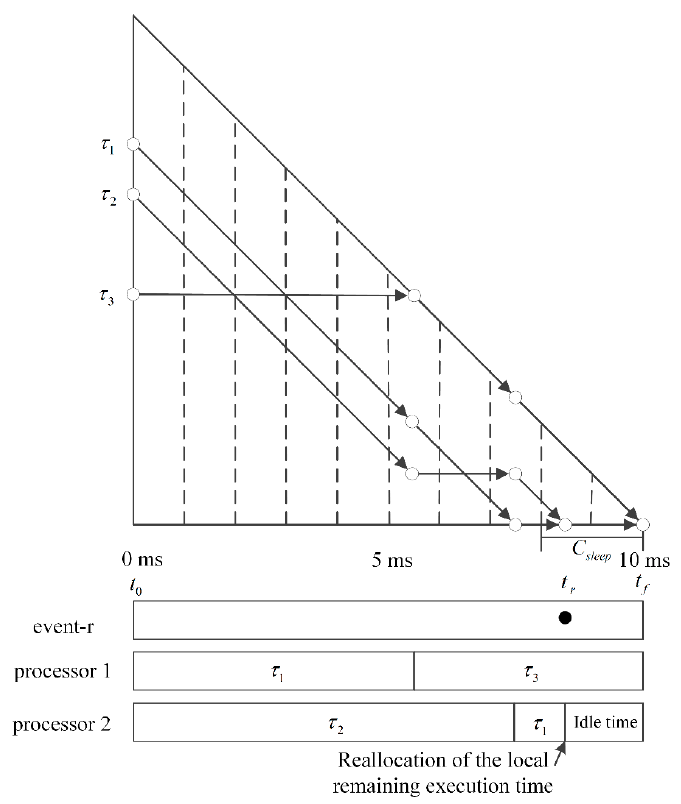
Figure 5. Example of the occurrence of an event-r.